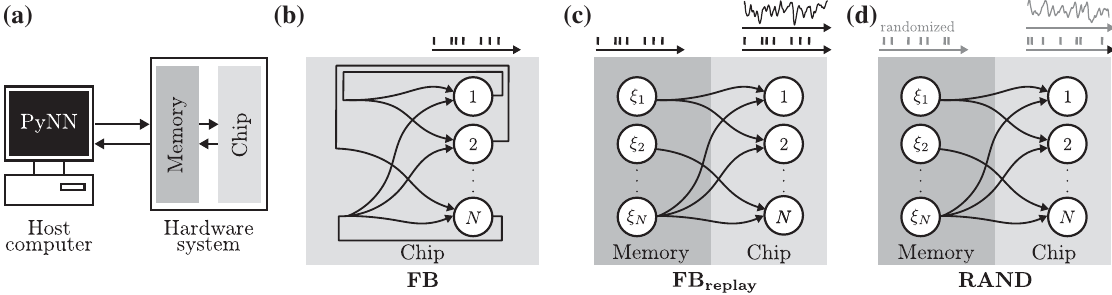
FIG. 2. Experimental setup. (a) Data flow of the Spikey system. For details, see Sec. II B. (b) Network with on-chip feedback connections (FB). Spikes from all neurons are recorded to the local memory. (c) Spikes of the FB network in (b) replayed from memory via off-chip spike sources ξ to neurons i (FB ). Spike times of ξ correspond to those recorded from neuron i in (b). Spikes from all i i replay neurons or the free membrane potential of one selected neuron are recorded. (d) Like (c), but spike times from (b) are randomized for each source ξ i